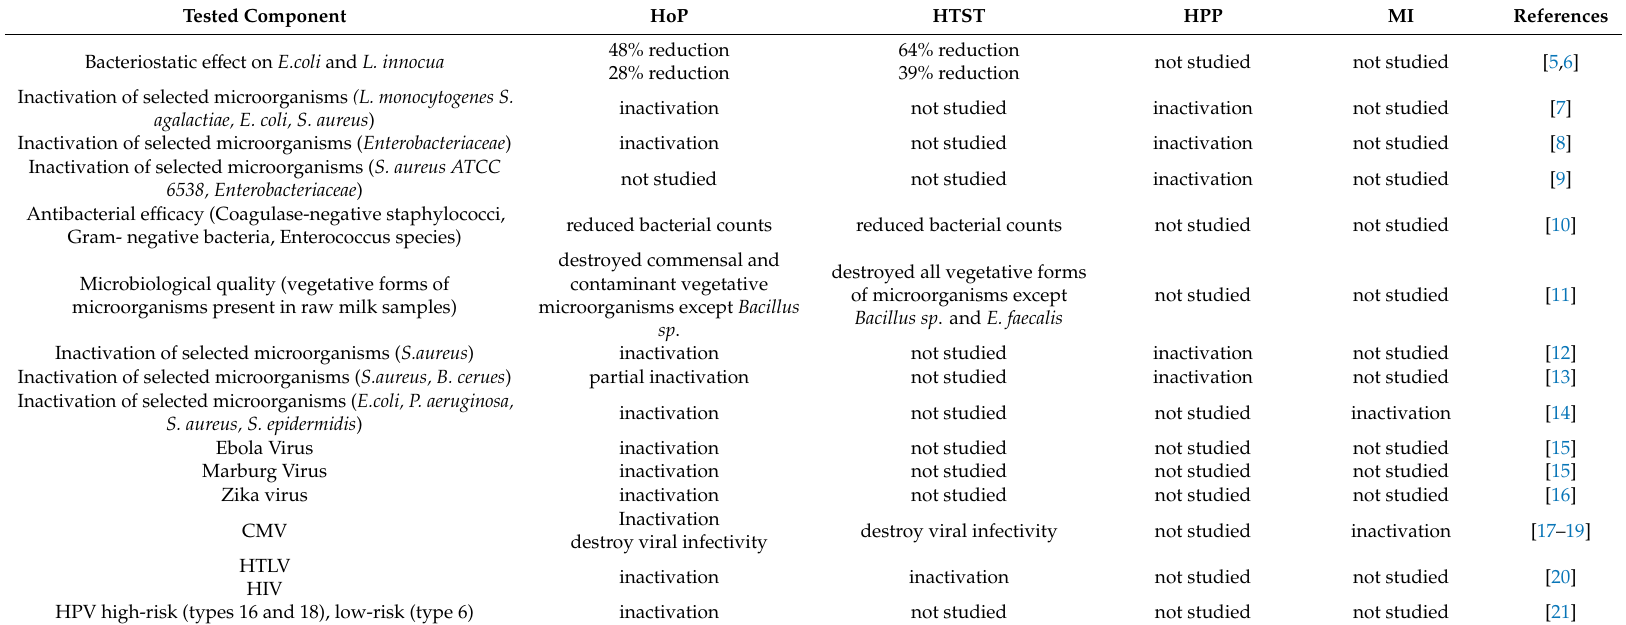
Table 1. Studies of Holder Pasteurization, High-Temperature Short-Time, High Pressure Processing and Microwave Irradiation HoP, HTST, HPP, MI on microbiological and viral components of human